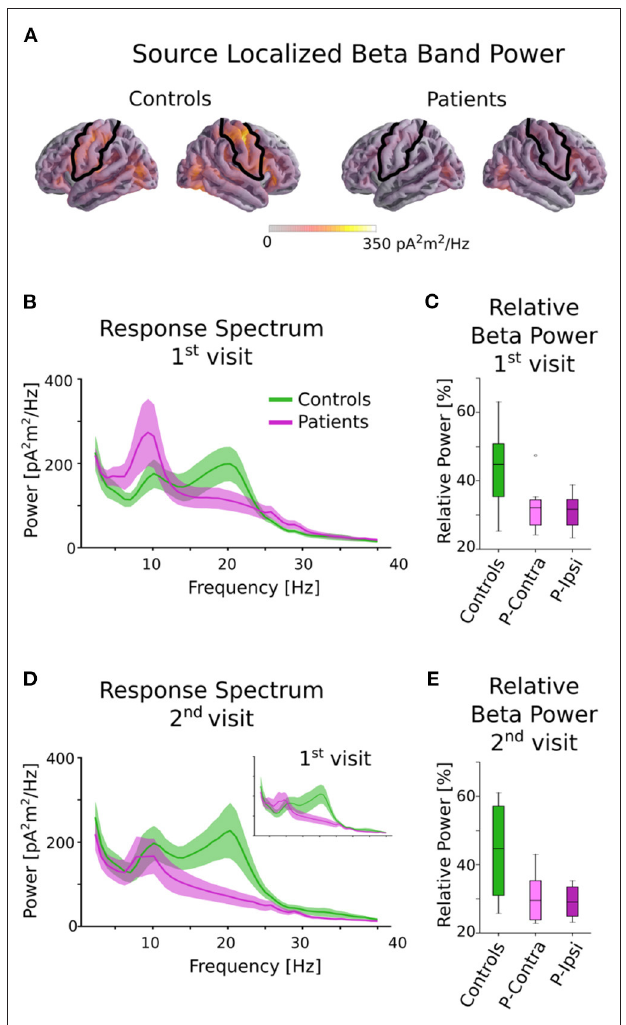
FIGURE 2 | Beta ERD and ERS for controls and patients. (A–D) The spectrograms for controls and patients (normalized w.r.t. baseline activity) are shown. The movement (button press) occurred at time t = 0. The dashed line indicates the beta band (13–25Hz) that was used for further analysis. (E,F) Beta power modulation per subject, computed as the average power in the beta band. Patients have reduced beta ERD/ERS. (G,H) Beta ERD/ERS (% change from baseline) for controls and patients, separated by ipsi- and contra-lesional hemispheres. Patients have reduced ERD and ERS compared to controls for both visits, but show no differences across hemispheres. The group difference is much larger for the ERS than for the ERD. Controls were recruited with similar age (within 5 years, mean [SD]; controls = 58 [13.1]; patients = 59.8 [15.7]) and sex ( n male, controls = 4, patients = 4), but controls had a higher level of education than patients (years of education: controls = 18.6 [3.6]; patients = 14.1 [4.4]). Patients performed worse in cognitive tasks compared to controls (MoCA controls =